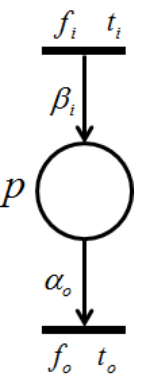
Figure 7. Single-input and single-output structure ( PN siso ).